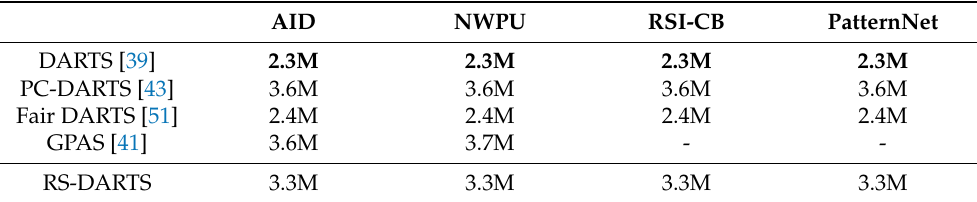
Table 8. Comparison of the number of model parameters during training of the optimal structural network model searched by RS-DARTS and other NAS methods (These boldface numbers represent the least number of model